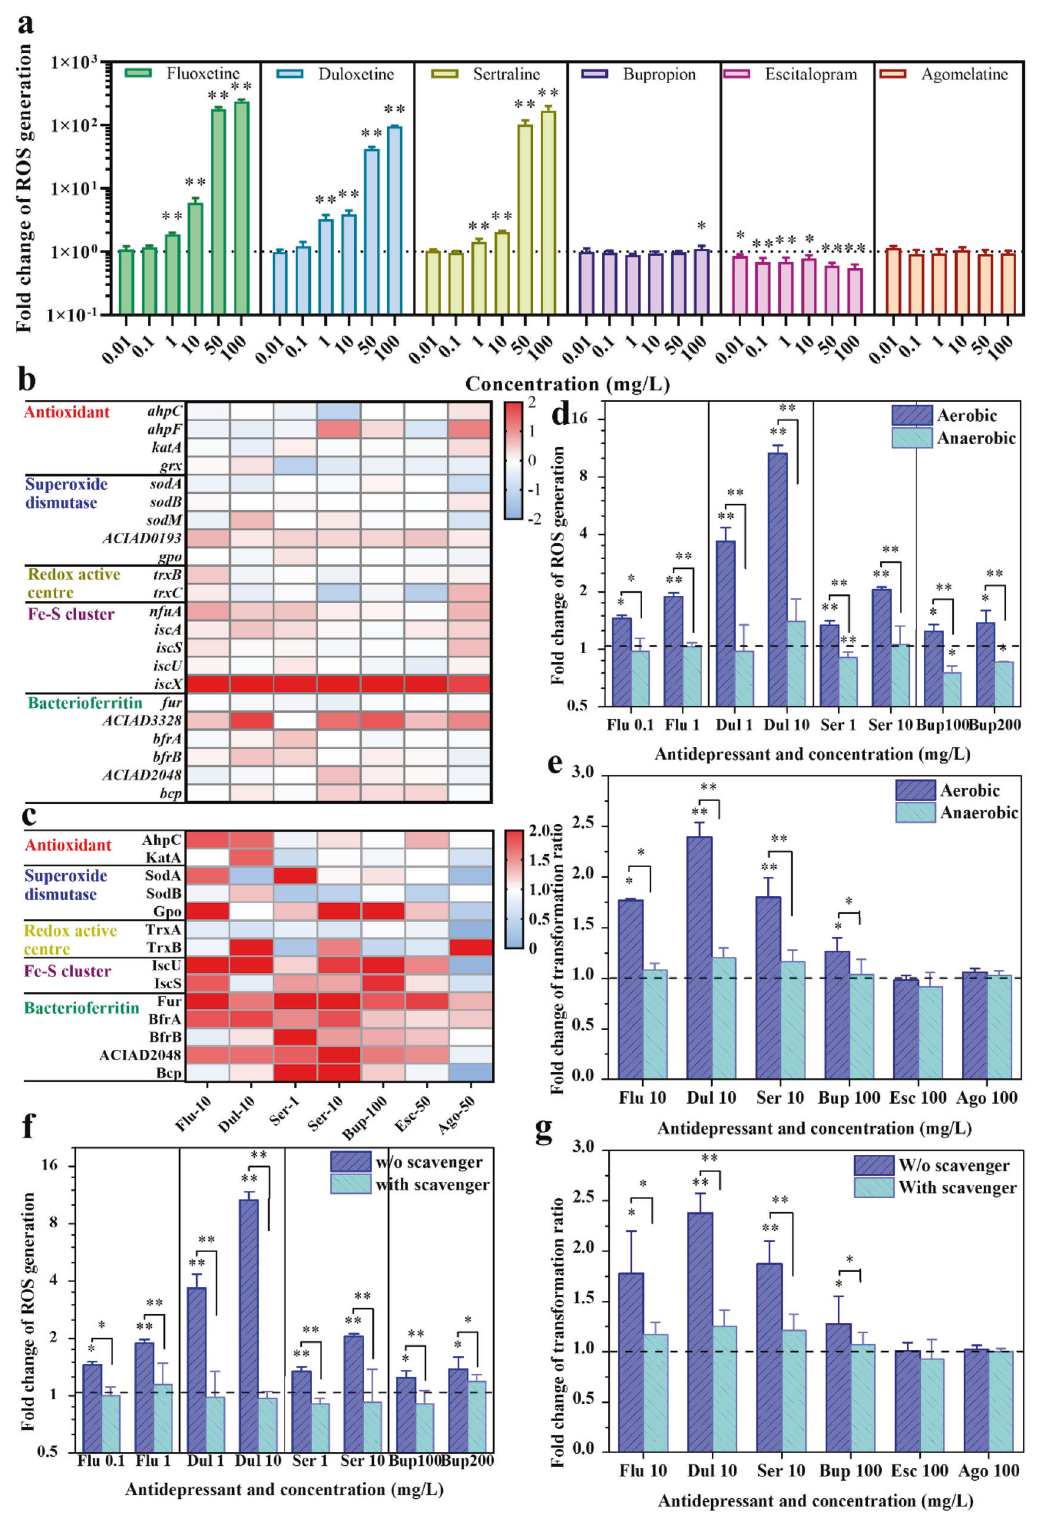
Fig. 2 Antidepressants stimulate the ROS generation of A. baylyi ADP1. a ROS generation of A. baylyi ADP1 after 2 h treatments of various antidepressants. Heat-maps showing the transcriptional changes ( b ) and translational changes ( c ) of oxidative stress-related genes under exposure to various antidepressants. Antidepressants-mediated ROS generation ( d ) and transformation of plasmid pWH1266 ( e ) under the anaerobic condition. Antidepressants-mediated ROS generation ( f ) and transformation of plasmid pWH1266 ( g ) with and without the addition of an ROS scavenger-thiourea (100 μ M). Signi fi cant differences between individual antidepressant-treated groups and the control groups (0 mg/L) were analysed with ANOVA and shown with * ( p adj < 0.05), ** ( p adj < 0.01). P values were corrected by the Benjamini/Hochberg